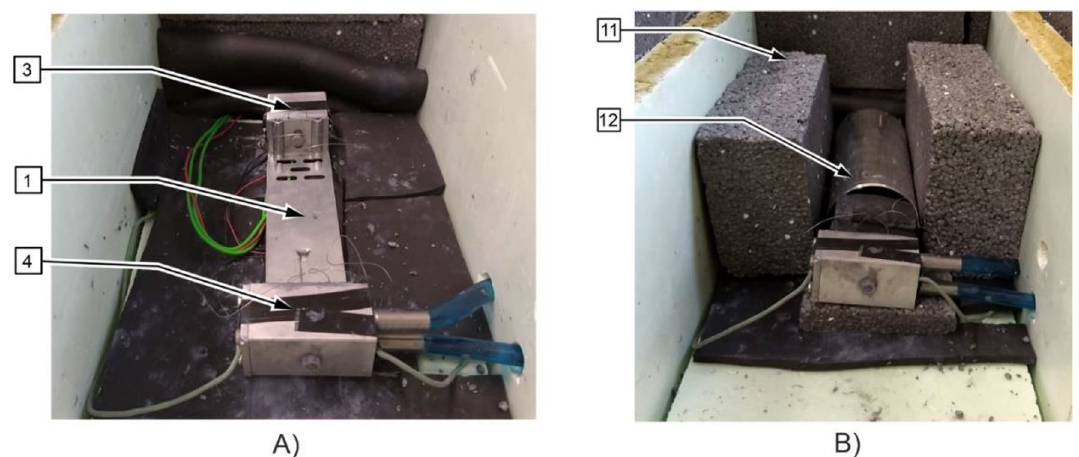
Figure 5. ( A ) View of the experimental section before being insulated and placed in the Dewar flask. Designations as in Fig. 4, ( B ) View of the experimental section after being placed in the Dewar flask and during the insulation process. Designations: 11—Styrofoam insulation, 12—Dewar